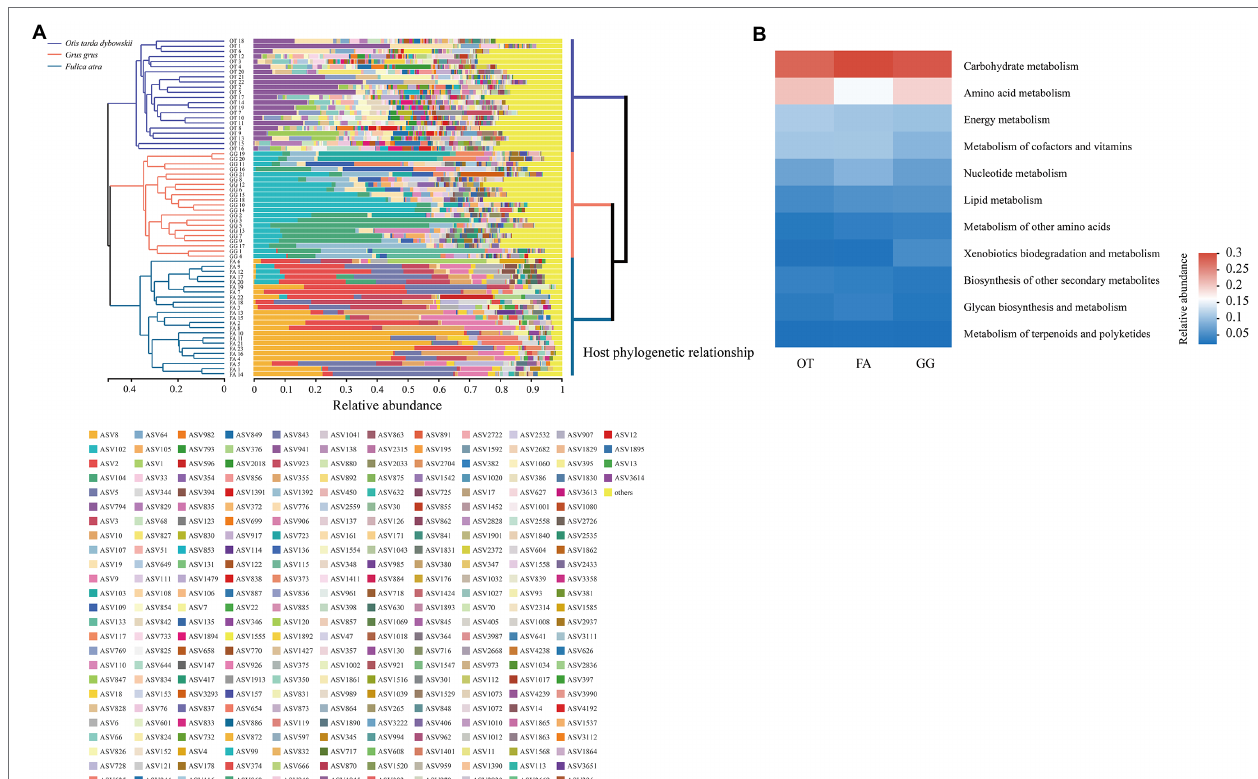
FIGURE 4 | (A) Left: The Unweighted Pair-group Method with Arithmetic Mean (UPGMA) based on Bray–Curtis distances showed the hierarchical clustering of the gut microbiota. Stacked barplot showed the ASVs in each sample, and the ASVs with relative abundance <0.01 were combined as “others.” Right: Host phylogenetic tree constructed using the brid tree tools. (B) Relative abundance of the metabolic pathway categories in the gut microbiota of the three wild bird species. OT, Otis tarda dybowskii ; GG, Grus grus ; and FA, Fulica atra